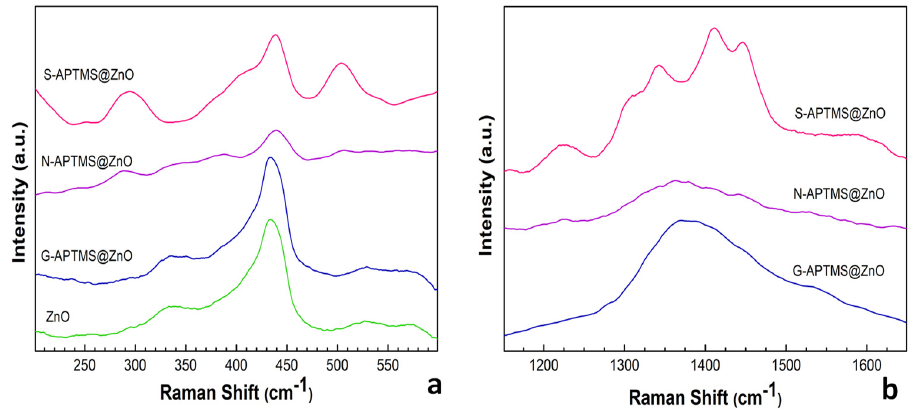
Figure 4. Raman spectra of ZnO and the coated samples N-APTMS@ZnO, G-APTMS@ZnO, and S-APTMS@ZnO. Panel ( a ) 200–600 cm − 1 , panel ( b ) 1100–1700 cm − 1 .